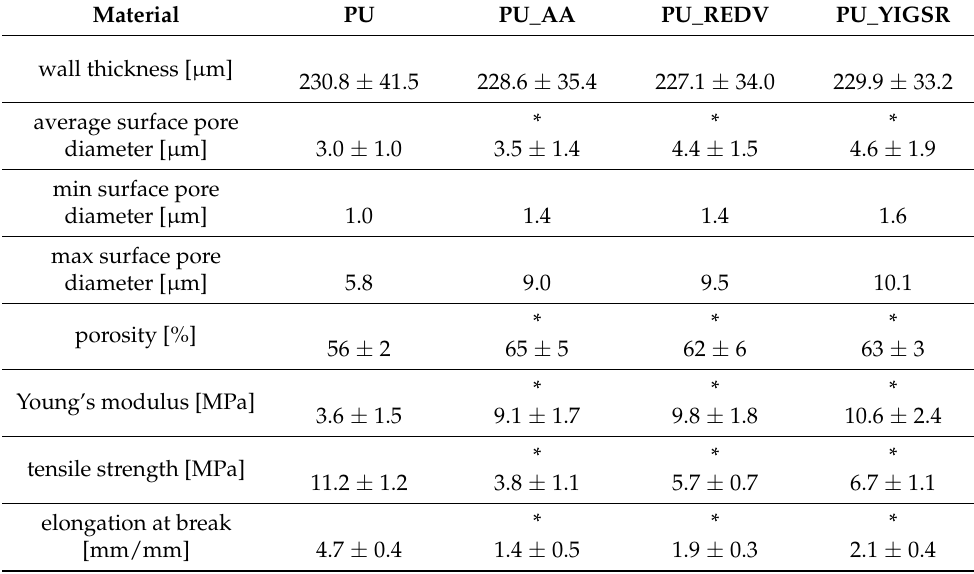
Table 1. Psychical and mechanical properties of obtained materials (MV ± SD).